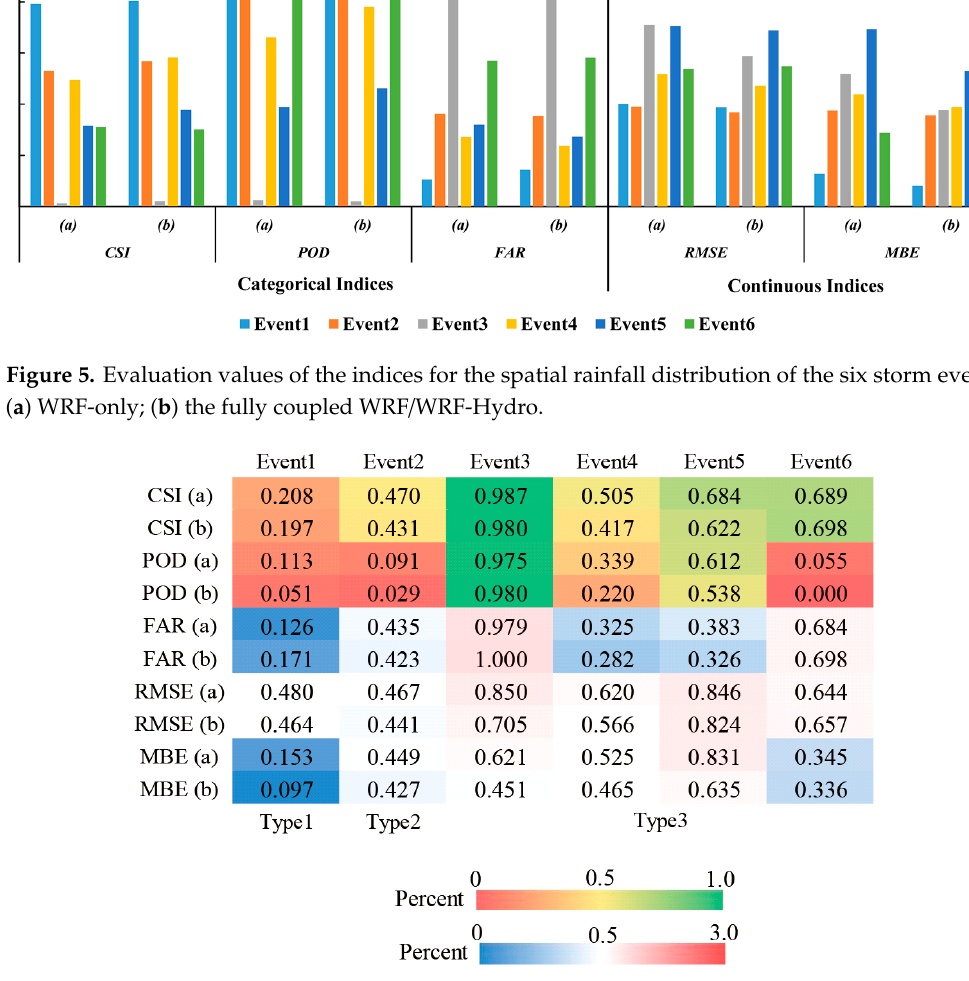
Figure 6. Spatial heat map of the indices errors: ( a ) WRF-only; ( b ) the fully coupled WRF/WRF- Hydro.